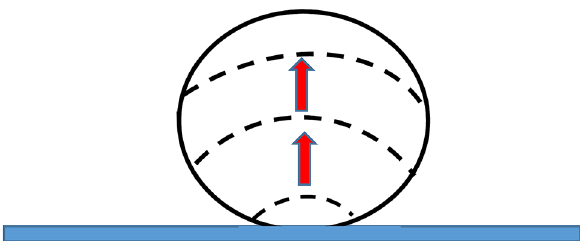
− 10 °C, thus evidencing ≅